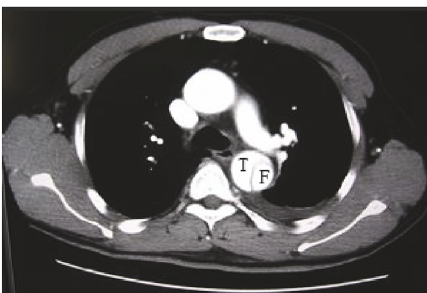
Figure 1: The true and the false